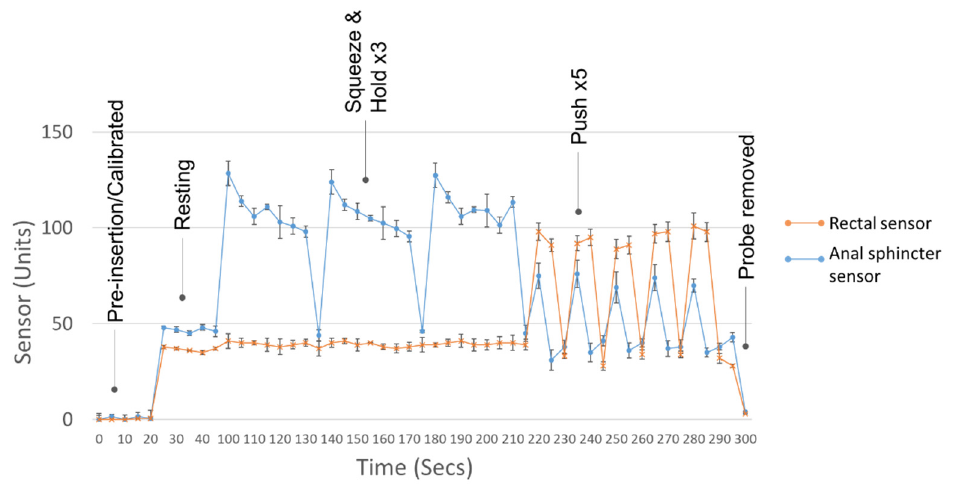
Figure 10. Biofeedback training session (biofeedback manoeuvres: rest, squeeze and hold, and push) performed three times over three consecutive days. Error bars are the standard deviation over the three days.